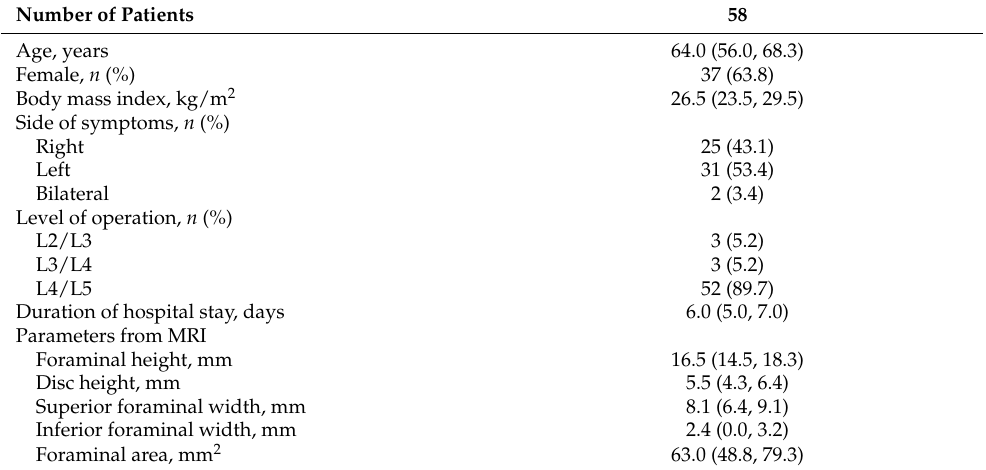
Table 1. Characteristics of the study